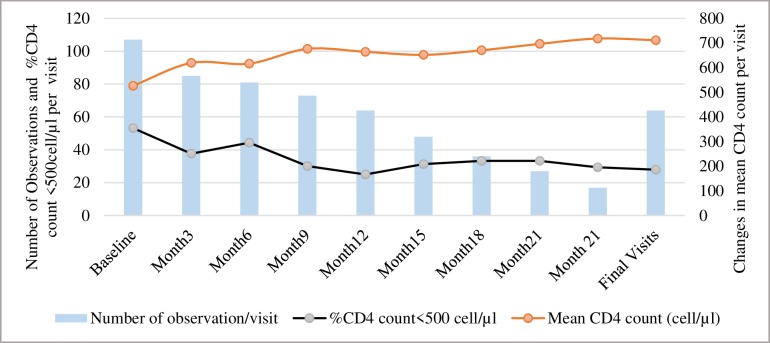
Time trends in mean CD4 and proportions of CD4<500 among HIV-infected FSWs on ART, Benin.N: Number of observations per visit %CD4 count<500 cell/μl: Proportion of participants with CD4<500 cell/μl during follow up Mean CD4 count: Changes in mean CD4 count during follow upFinal visits: Included 63 participants who had final visits from Month 3 onwards and one early final that occurred at Month 3. Subjects with final visits at Day 14 (one at the end of the study for a seroconverting participant from the PrEP component of the study and two early final visits because of active withdrawal) were excluded from this analysis.